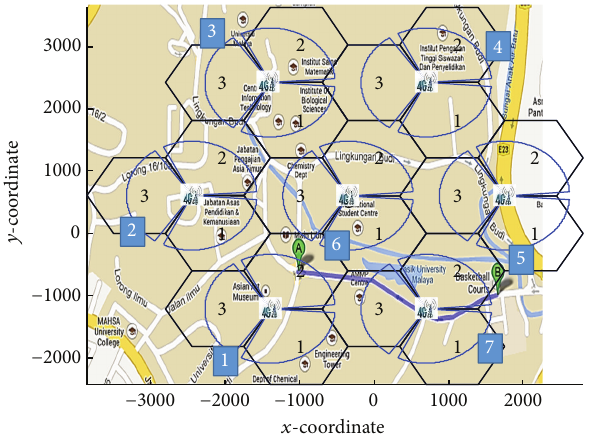
Figure 3: MS movement at the University of Malaya